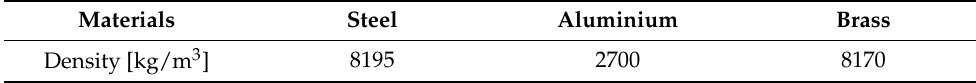
Table 1. Density of materials.